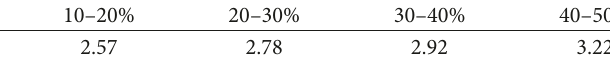
Table 3: The distribution of measured headways in different scenarios of vehicle composition. Proportion of